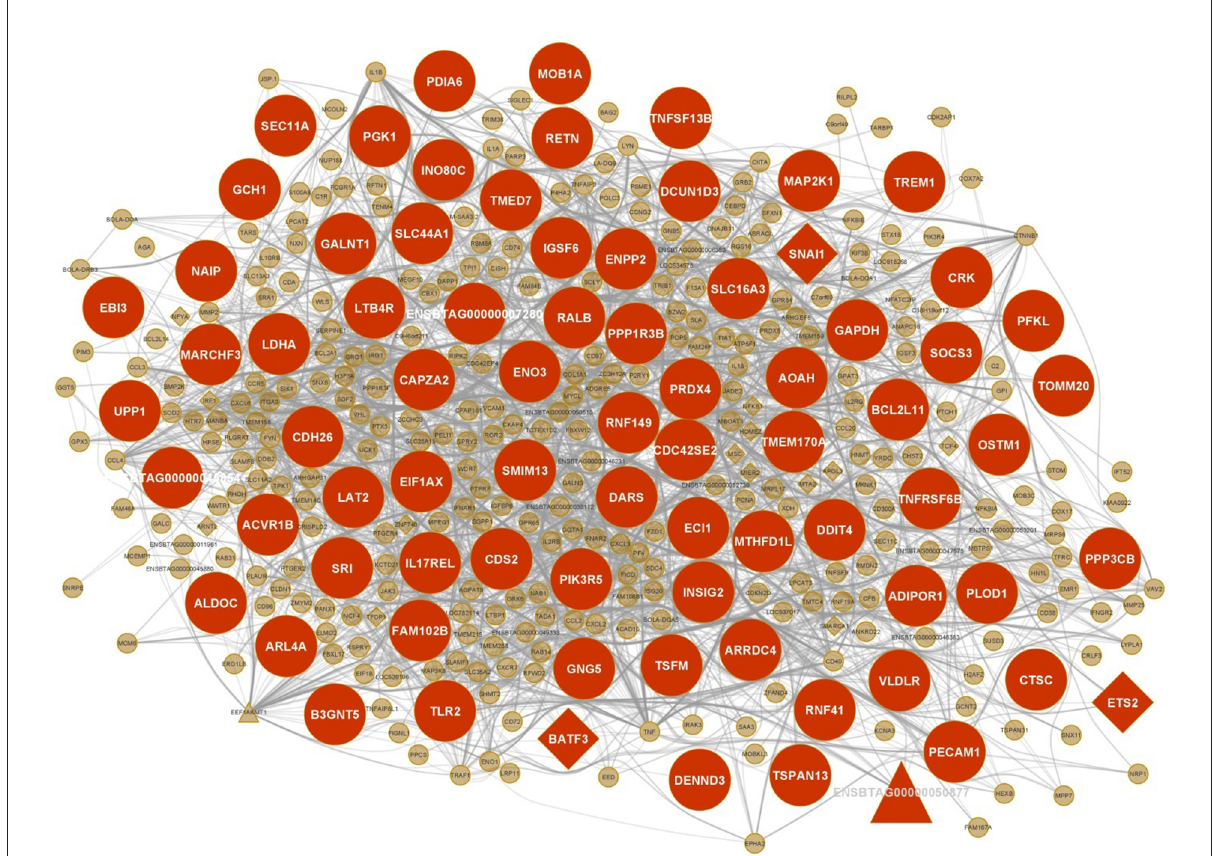
FIGURE6 Integrated regulatory network of sienna3 module. Each node represents a gene and each edge represents the interaction between genes. mRNAs, lncRNAs and TFs are indicated with circles, triangles and diamond shapes, respectively, and the larger shapes represent hub genes.